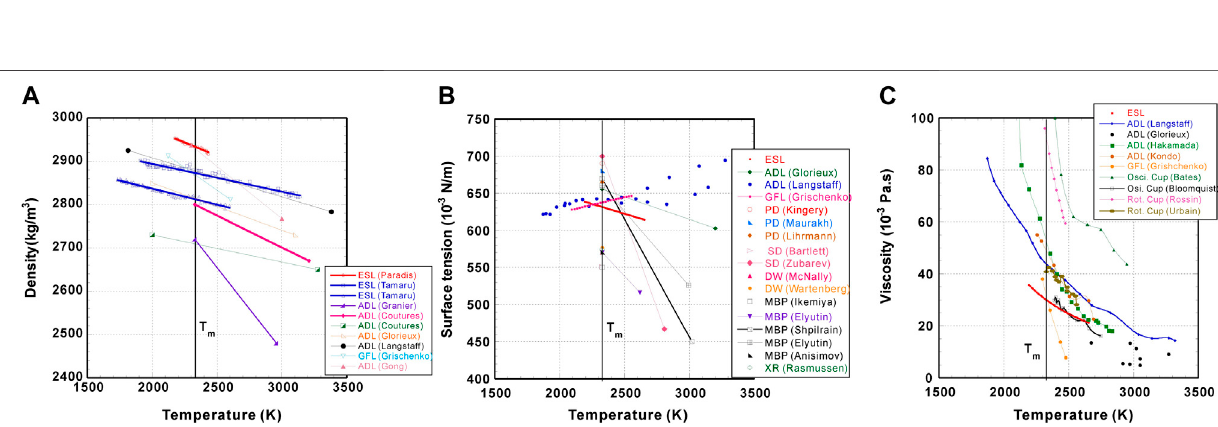
Frontiers in Materials |